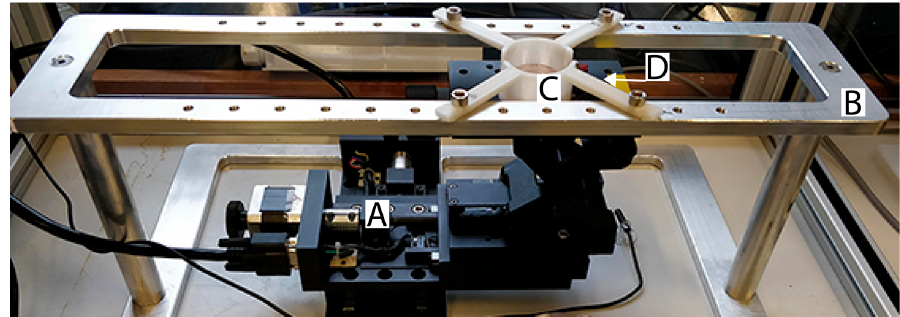
Figure 1. Overview of the automated external alpha particle irradiation set-up. ( A ) Two motorized linear stages connected to the Motion controller and the PC. ( B ) Aluminum frame as frame for the device (Design S1). ( C ) Culture dish holder (Design S2). ( D ) Radioactive source collimator (Design